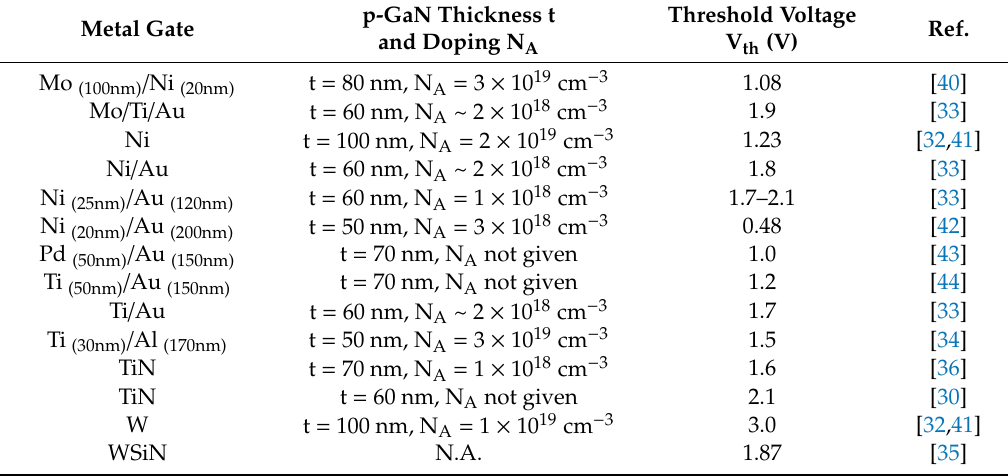
Table 2. Survey of literature data on normally-o ff HEMTs with p-GaN gates obtained using di ff erent Schottky